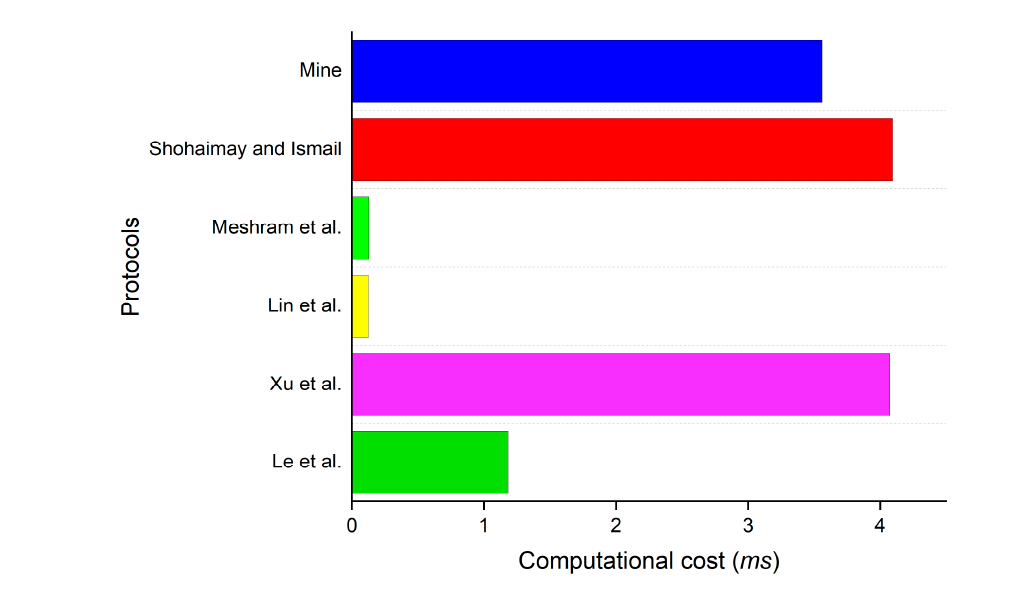
Figure 6. Computational cost of a single communication session in different protocols [22,24–27].